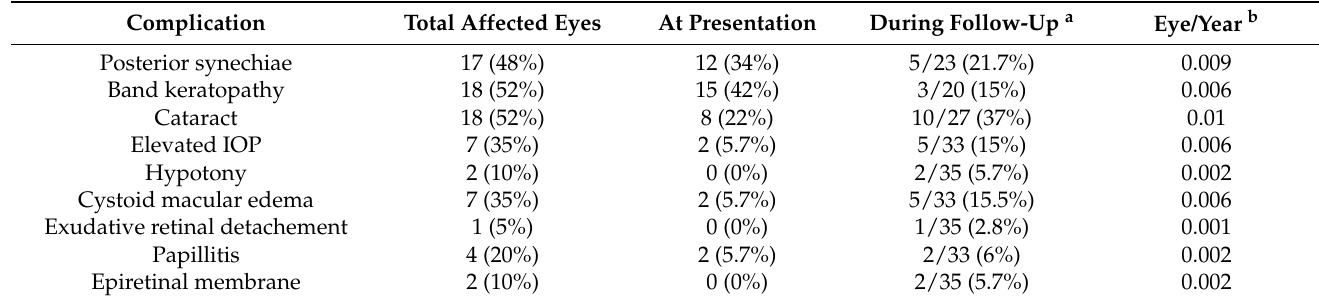
Table 2. Incidence of ocular complications at baseline and during